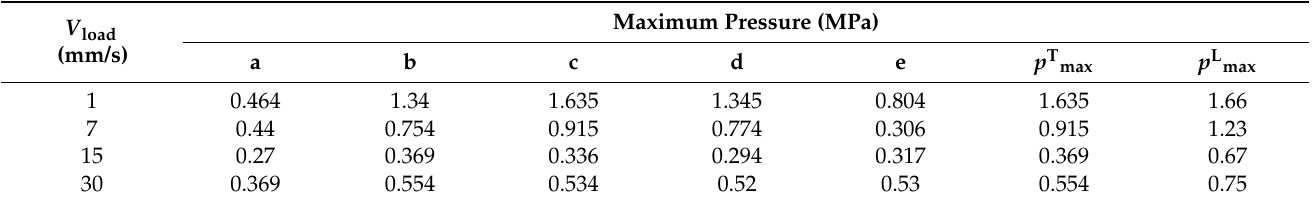
Table 5. The maximum LIP at five